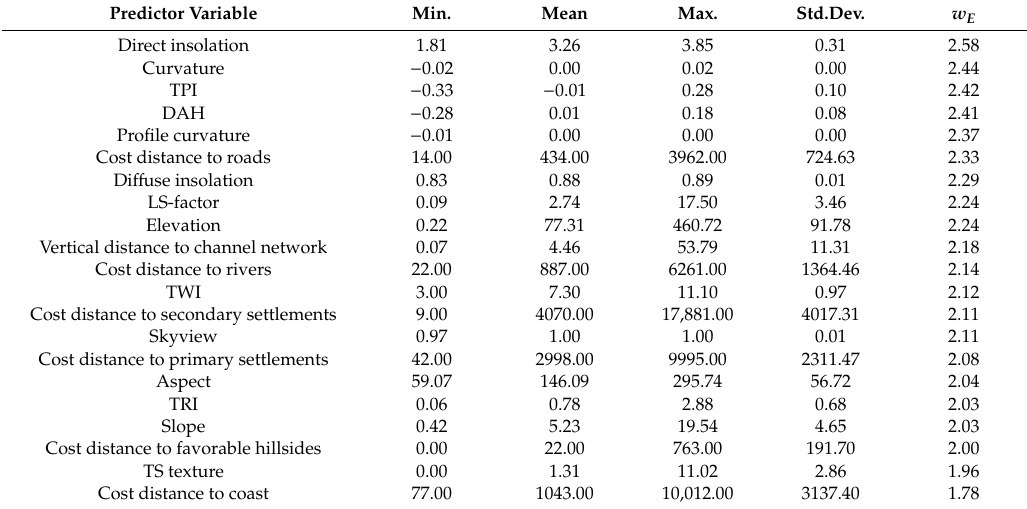
Table 3. Descriptive statistics of the predictor variables. The table is sorted by decreasing w E . Predictor